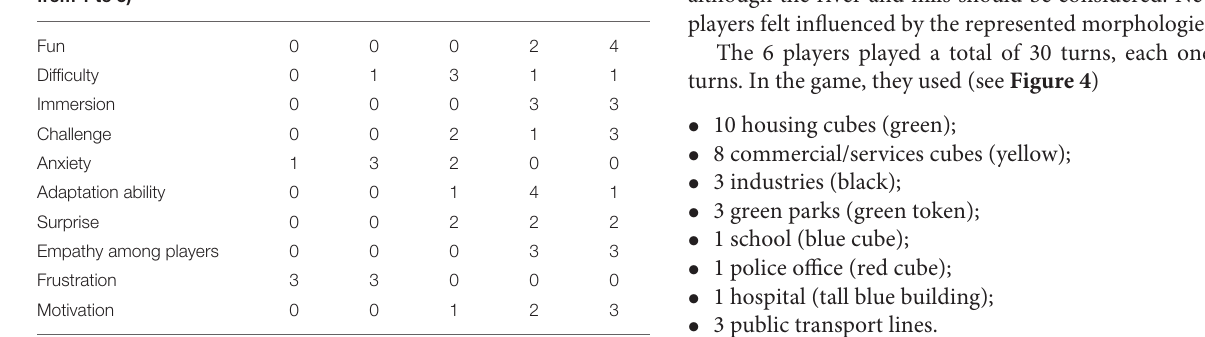
TABLE 3 | Experiences and perceptions during game play of the gaming session. Experiences and perceptions during gameplay (classification from 1 to 5)